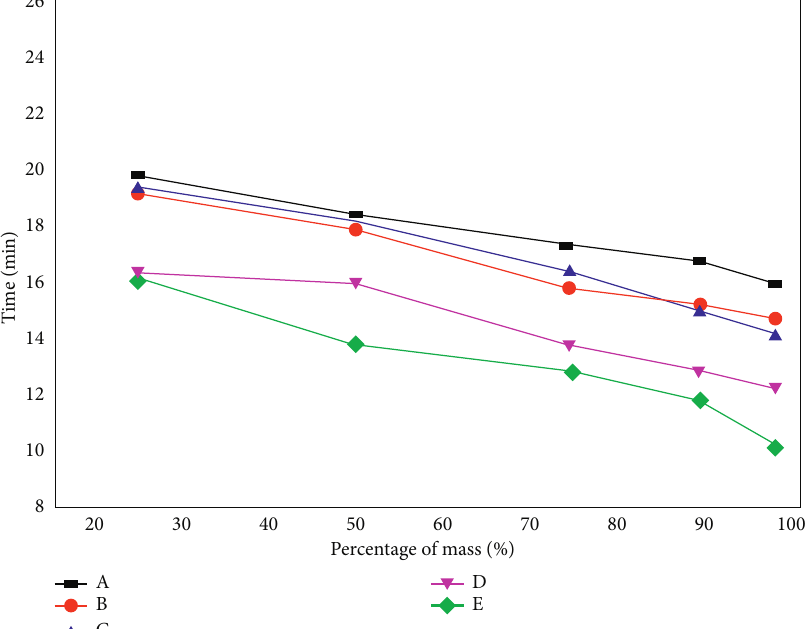
Figure 9: The graph between mass loss and time of the hybrid composite.